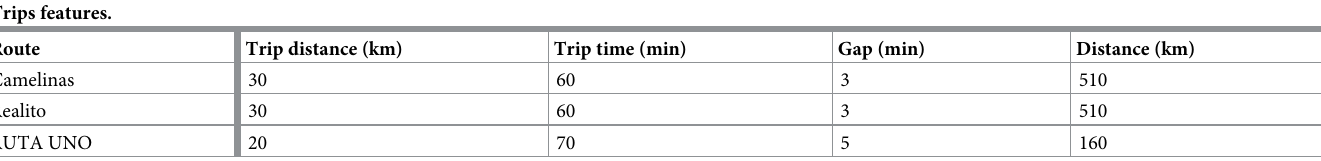
Table 1. Identified service trips for a workday. Trips